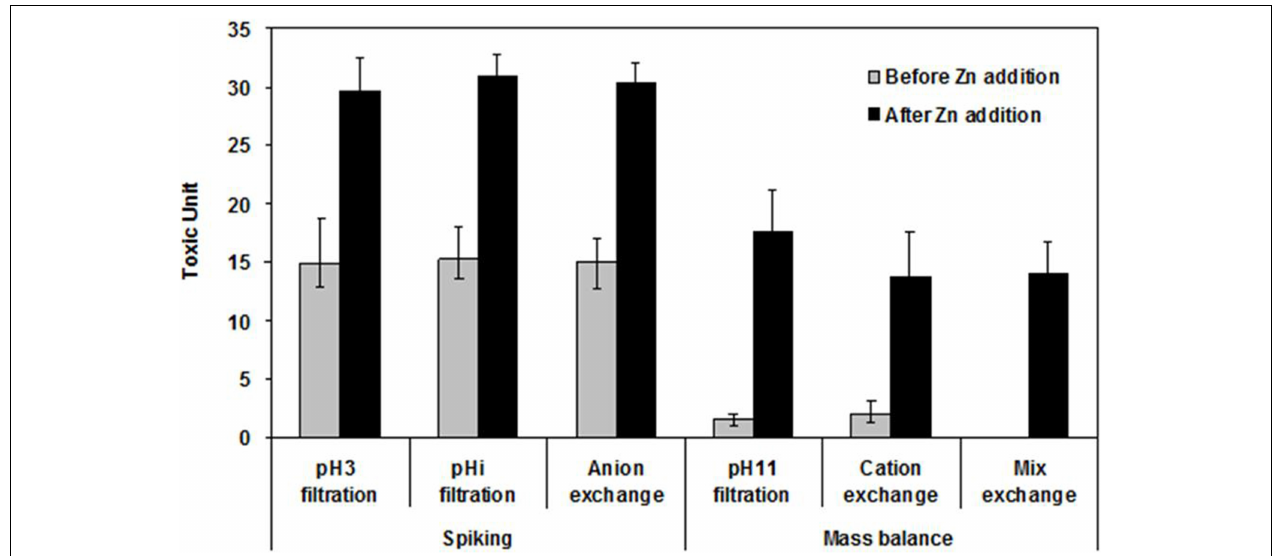
FIGURE 6 | Phase III toxicity confirmation by spiking and mass balance treatments. The concentration of added Zn was 25.05mg · L − 1 which was the concentration found in the final